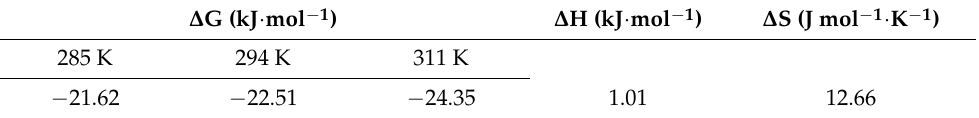
Table 6. Thermodynamic parameters for the crystal violet adsorption onto Bathurst burr powder.